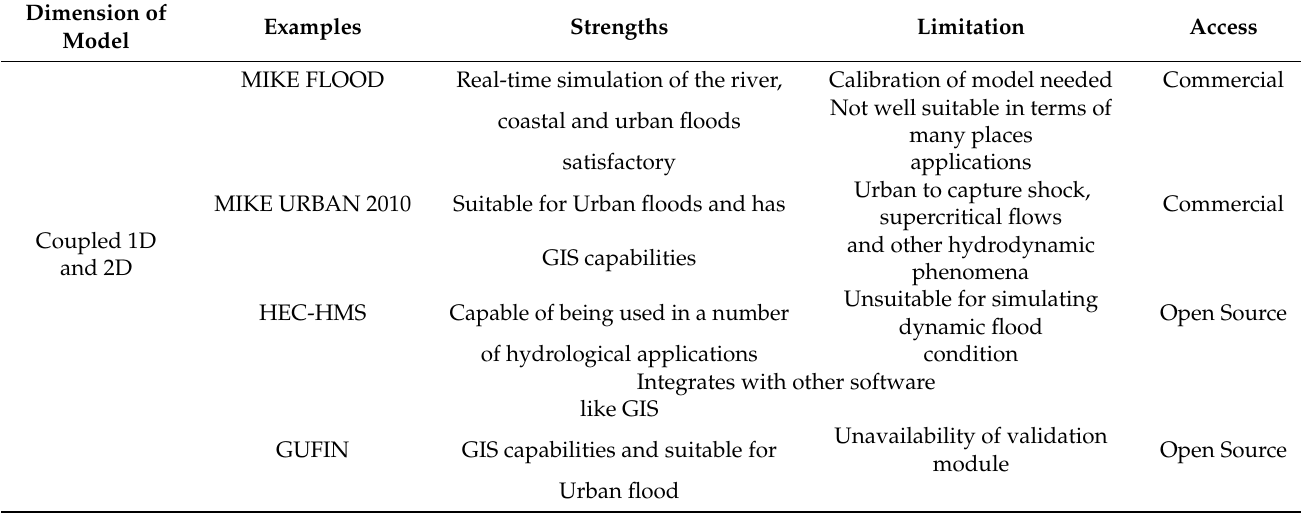
Table A4. Summary of the Coupled 1 and 2-dimensional numerical tools in flood modelling.